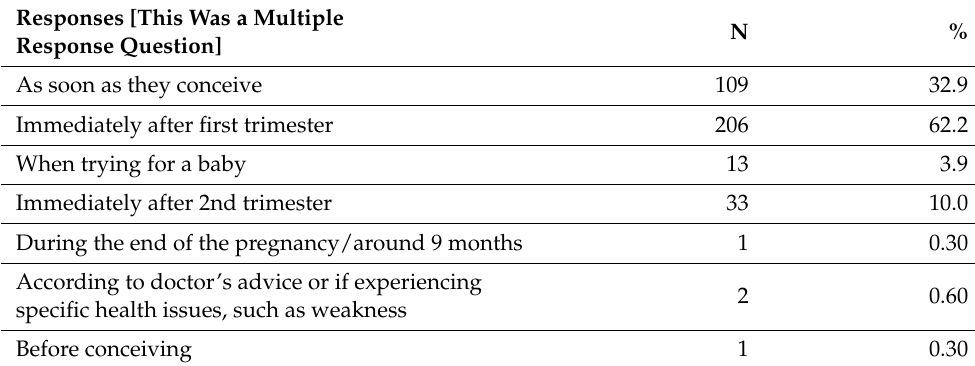
Table 7. Awareness of timing to start consuming pregnancy supplements by pregnant women.